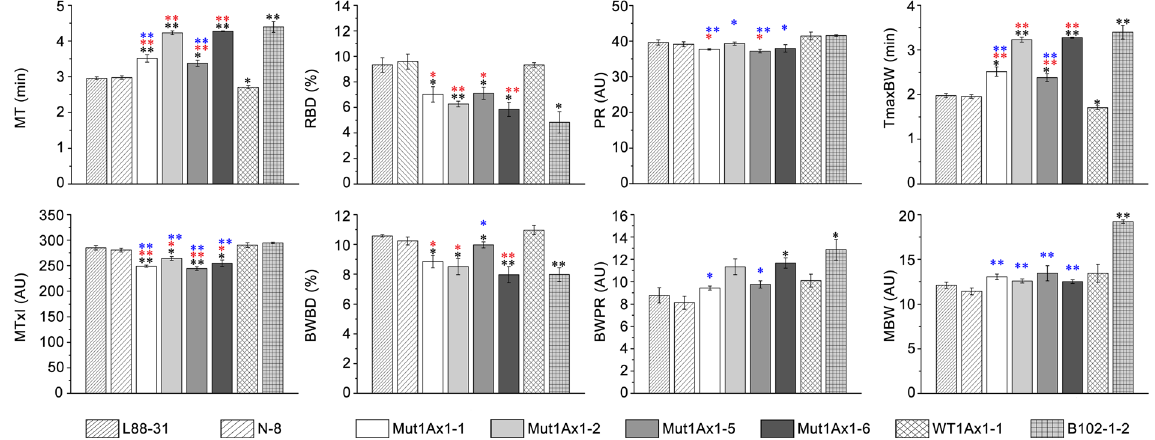
Figure 3. Effects of Mut1Ax1 on the dough mixing properties. Comparisons of the eight mixograph parameters among dough samples of all lines. Bars represent the mean ± SEM (n = 3). * / ** Show the comparisons between all transgenic lines and negative controls (L88-31 and N-8) on the mixing parameters, while and represent comparisons between transgenic lines expressing mut1Ax1 and line WT1Ax1-1 and comparisons between those lines and line B102-1-2, respectively ( * P < 0.05, ** P < 0.01 by Student’s t-test).